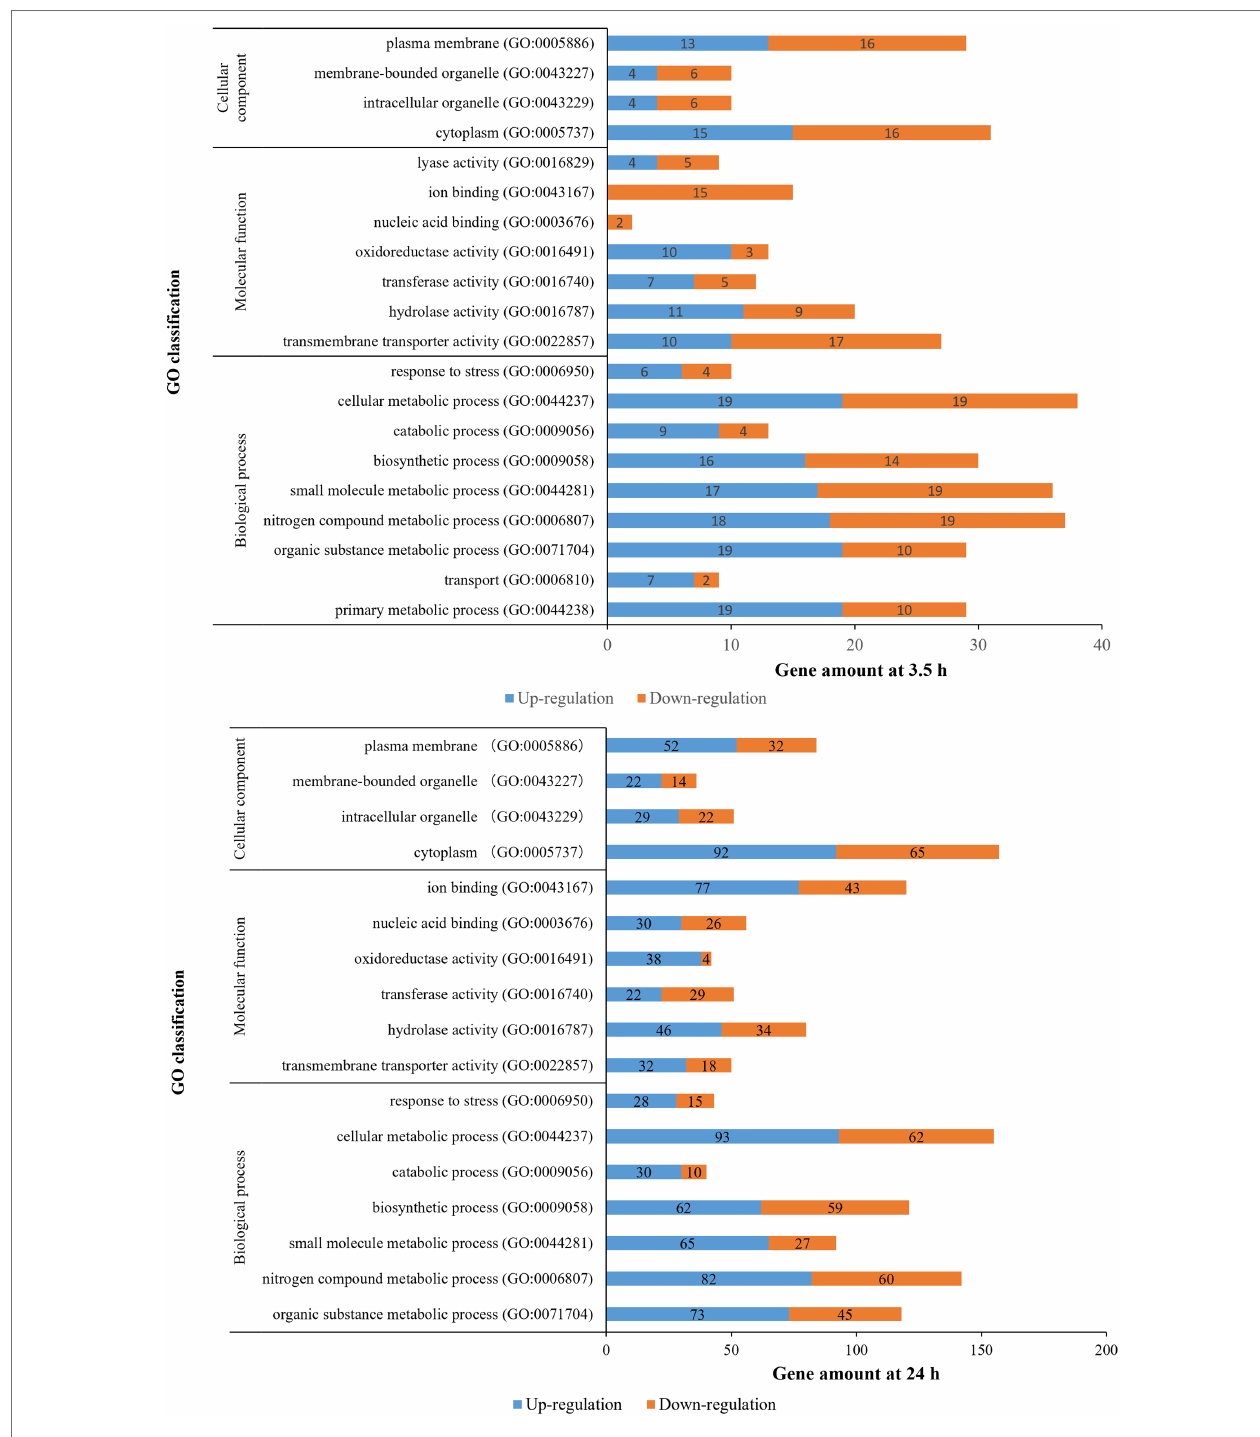
FIGURE 4 | Gene ontology classification of DEGs for OLE treatments in L. monocytogenes